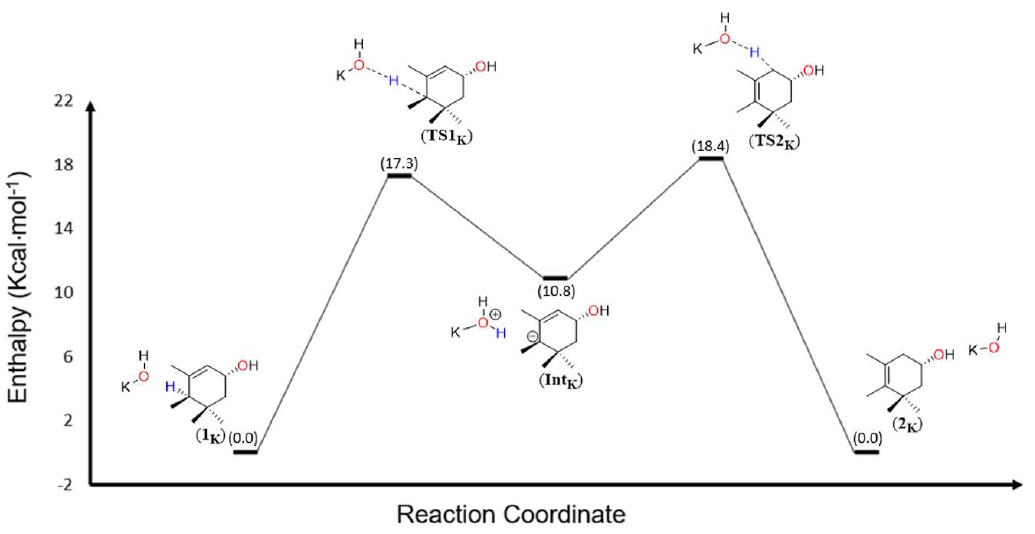
Figure 2. Energy profile calculated at the (PCM: n -butanol)M06-L/6-311 + G(2d)//M06-L/6-31G(d) level for the conversion of 1 into 2 .